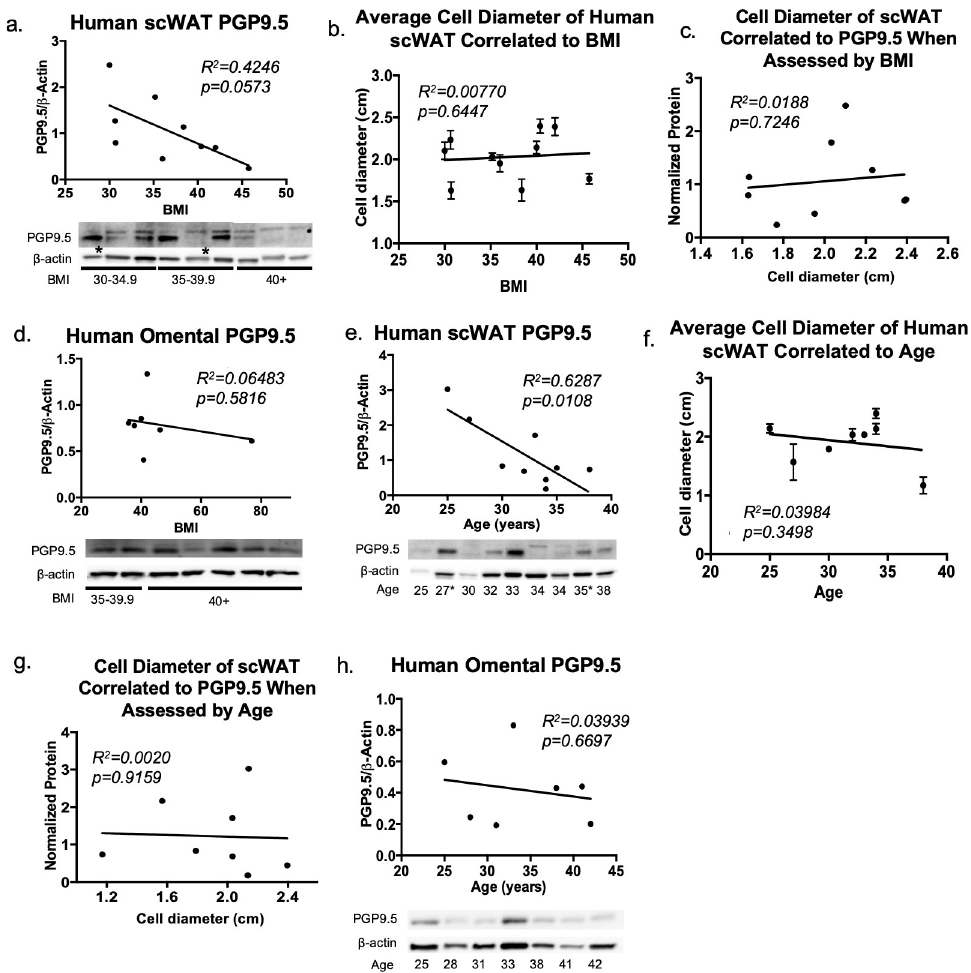
Fig 3. Human subcutaneous and omental white adipose tissue innervation. In human scWAT, protein levels of pan- neuronal marker PGP9.5 were measured by western blotting; linear regression analysis was performed for assessment of normalized protein levels compared to body mass index (BMI) (a). Average cell diameter in scWAT of human samples when assessed by BMI (b), and normalized protein expression plotted against average cell size (c). Protein levels of PGP9.5 were measured in omental adipose by western blotting; linear regression analysis was performed for assessment of normalized protein levels compared to BMI (d). Protein levels of PGP9.5 measured in human scWAT, linear regression analysis was performed for assessment of normalized protein levels compared to age (e). Average cell diameter in scWAT of human samples when assessed by age (f), and normalized protein expression plotted against average cell size (g). Protein levels of PGP9.5 were measured in omental adipose by western blotting; linear regression analysis was performed for assessment of normalized protein levels compared to age (h). Western blot data were normalized to β - actin, band intensities were quantified in Image J, and analyzed by two-tailed Student’s t-test. Protein expression was normalized to β -Actin and band intensities were quantified in Image J. Cell diameter was measured from images of histological cross-sections of adipose tissue from each patient, averaged (n = 3), and analyzed by linear regression. Due to limitations of available samples from the BNORC adipose tissue core at Boston Medical Center, the BMI distribution of omental adipose was clustered around 40. Error bars are SEMs. For (a,e) N = 9 BMI cohort, N = 9 Age cohort. For (a,e) � indicates individuals with diagnosed diabetes. The majority of human samples were females, see S1–S3 Tables for clinical